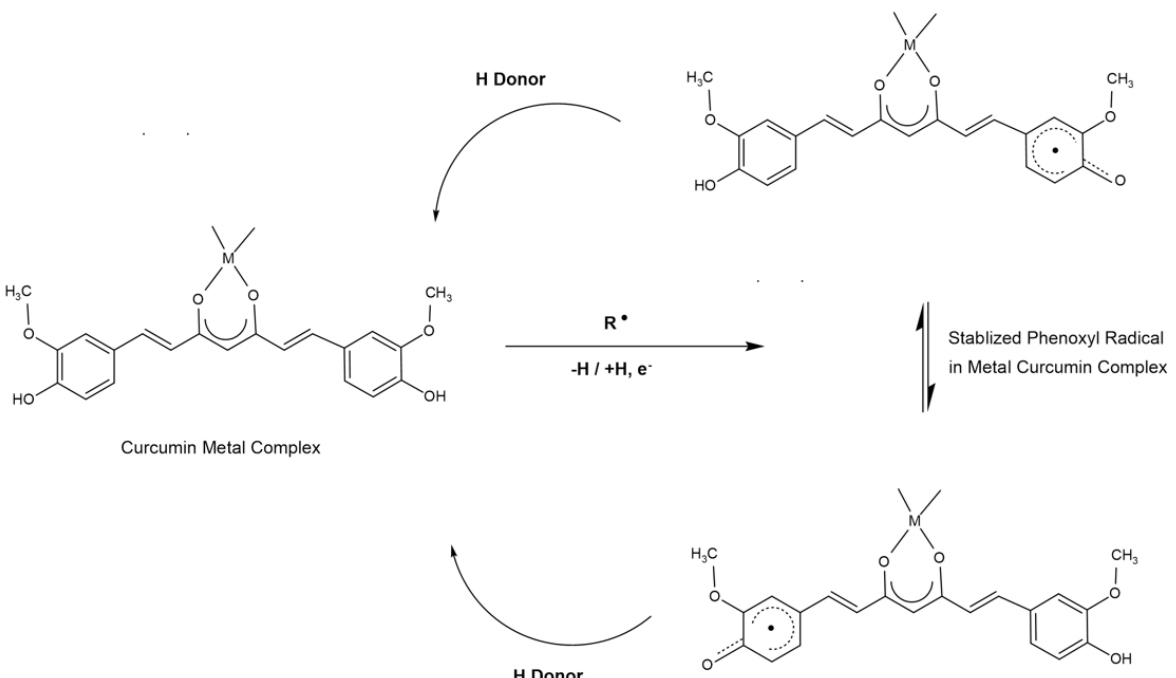
Figure 4. Free radical binding mechanism to the metal–curcumin complexes.